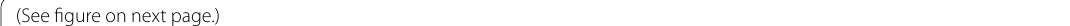
(See figure on next page.) Fig. 6 Effects of rapamycin combined with DAPT on autophagy and the EMT in HLE-B3 cells cultured under high-glucose conditions.. HLE-B3 cells were stimulated with 30 mM glucose (HG), then treated with DMSO solvent (DMSO), 200 nM rapamycin (RAPA), 5 μM DAPT (DAPT), and combination of 200 nM rapamycin with 5 μM DAPT (R D) for 24 h, respectively. A The expression of E-cadherin, ZO-1, α-SMA and Fibronectin + in HLE-B3 cells from each group was detected using Western blotting at 24 h. Statistical analysis of the relative expression of E-cadherin ( B ), ZO-1 ( C ), α-SMA D and Fibronectin ( E ), n 3. Cell migration after exposure to different treatments for 24 h was detected by performing a transwell = assay and scratch wound assay. Representative images and results of the transwell assay ( F , G , n 3, bar 100 μm) and scratch wound assay ( H , I , = = n 3, bar 200 μm). J The expression of molecules in the autophagy signaling pathway and autophagy marker proteins. Statistical analysis of the = = relative levels of LC3II/I ( K ), SQSTM1/p62 ( L ), p-mTOR/mTOR ( M ) and p-ULK1/ULK1 ( N ), n 3. O The expression of proteins in the Notch signaling = pathway. Quantification of the relative levels of Jagged1 ( P ), Notch1 ( Q ), NICD ( R ) and Snail ( S ), n 3. ns indicates P > 0.05; * P < 0.05, ** P < 0.01, = *** P < 0.001 and **** P < 0.0001 vs. NC group; # P < 0.05, ## P < 0.01, ### P < 0.001 and #### P < 0.0001 vs. DMSO group; ★ P < 0.05, ★★ P < 0.01, ★★★ P < 0.001 and ★★★★ P < 0.0001 vs. RAPA group; ◆ P < 0.05, ◆◆ P < 0.01, ◆◆◆ P < 0.001 and ◆◆◆◆ P < 0.0001 vs. DAPT